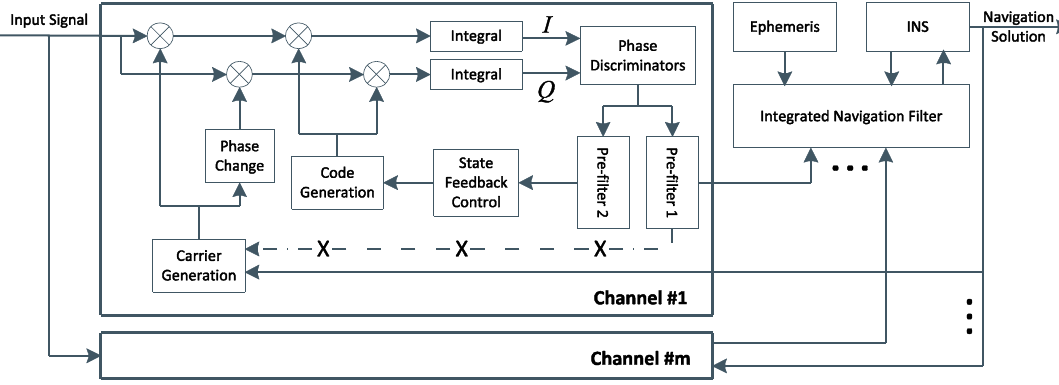
Figure 2. The structure of the ultra-tight GPS/INS integration.